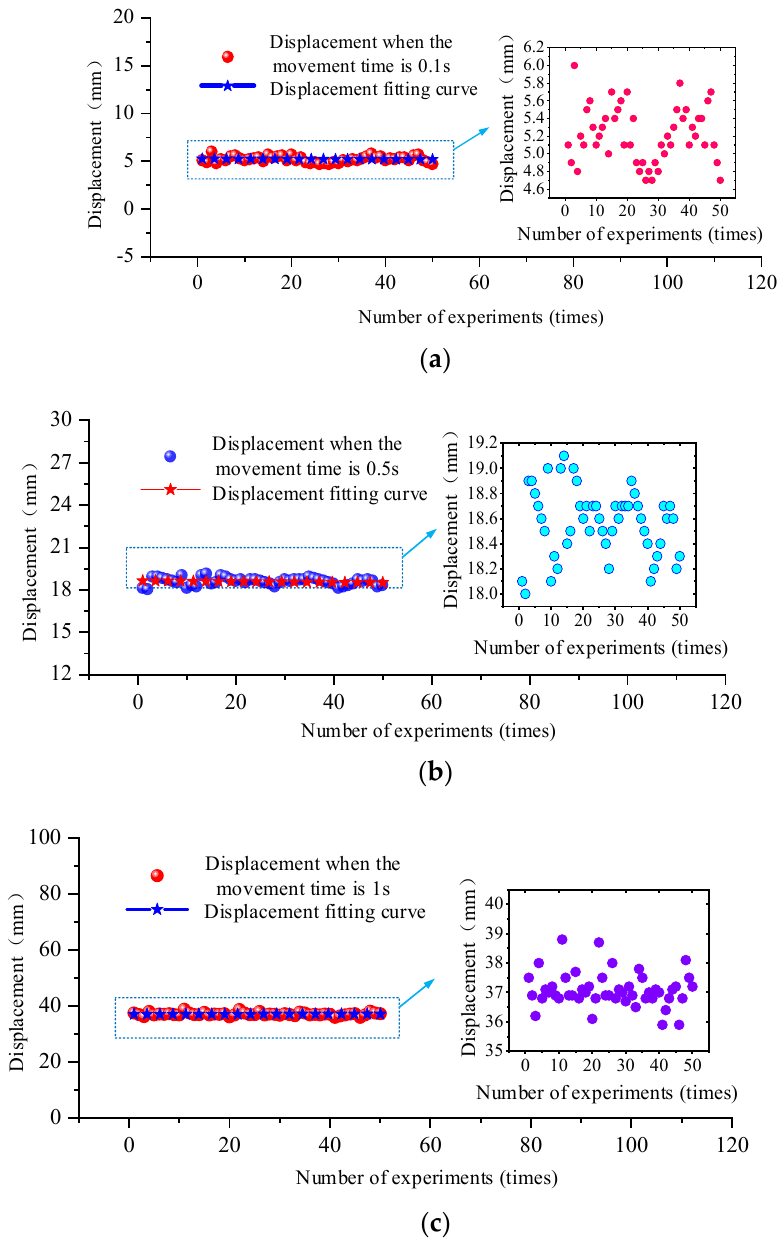
Figure 11. Variation curve of displacement with time during column lifting movement of the column cylinder of hydraulic support. ( a ) shows the displacement fitting curve under the condition of multiple experiments and movement time of 0.1 s; ( b ) shows the displacement fitting curve under the condition of multiple experiments and movement time of 0.5 s; ( c ) shows the displacement fitting curve under the condition of multiple experiments and movement time of 1